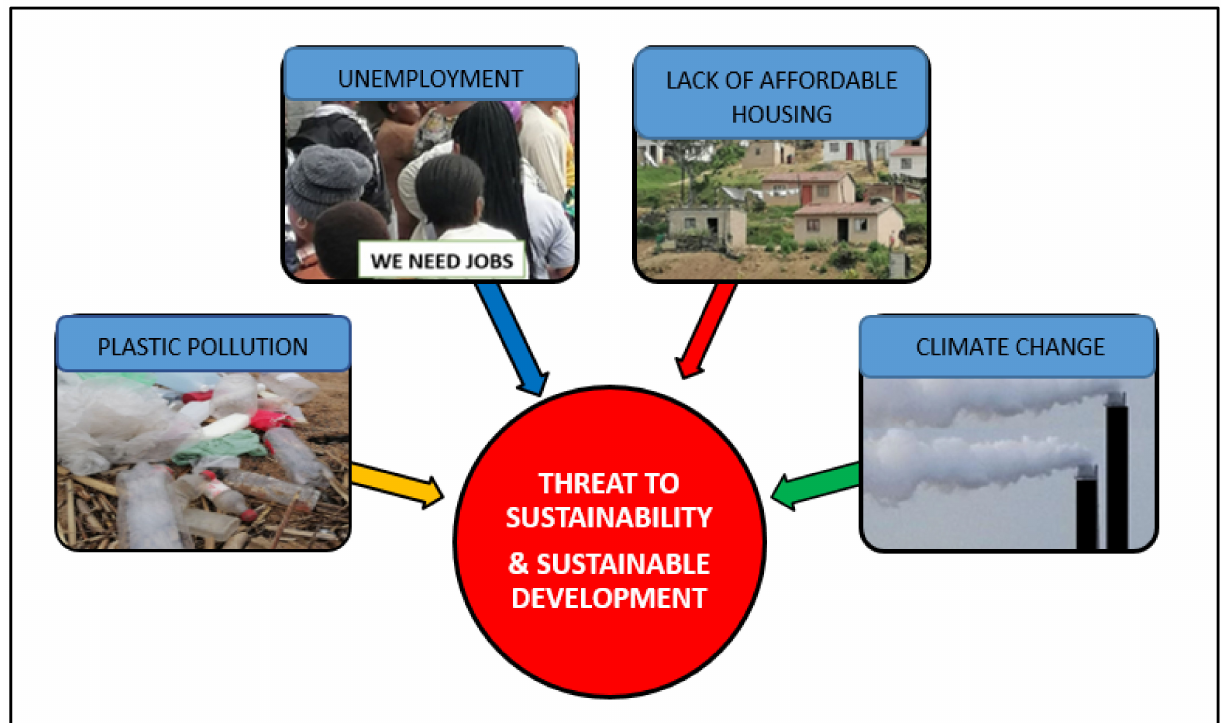
Figure 2. Four emerging global